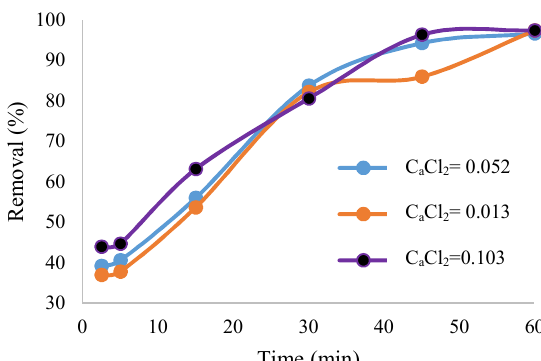
Fig. 7. Changes in the efficiency of removal of erythrosine B dye in different concentrations of sodium chloride in the US/S 2 O 82- process (pH: 3; initial concentration of dye, 50 mg/L and concentration of persulfate, 0.003